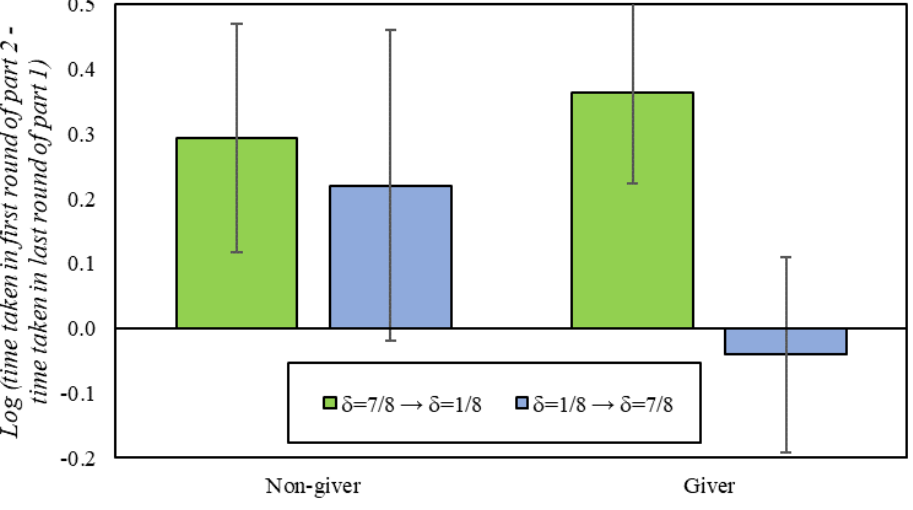
Figure 5. Difference in reaction times between the first round of the second part of the experiment and the last round of the first part of the experiment. In addition, 95% confidence intervals clustered by